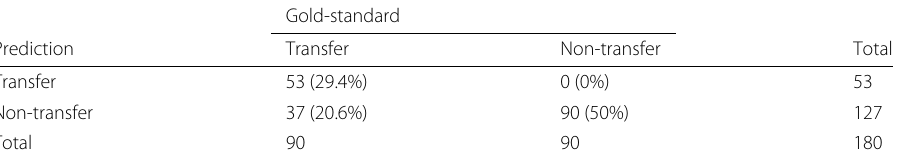
Table 3 Confusion matrix of image similarity comparing (NMSE) Gold-standard Prediction